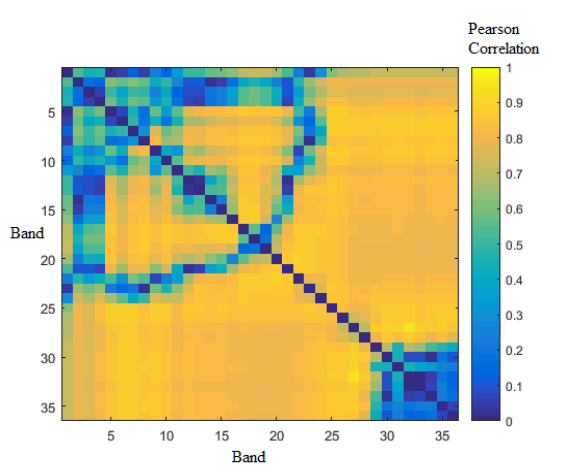
Figure 3. The Pearsons correlations between different band combinations of NDVI and reference measurements of biomass. In the case of biomass estimation, the correlations between the ground truth and the remote sensing features were over 0.9 for the spectral features and CHM at best. The best correlation values of over 0.93 were obtained with the GRVI-data from UAV and MAV RGB camera and the UAV hyperspectral camera; the UAV FPI NDVI estimates were marginally poorer. The highest resolution CHM, captured